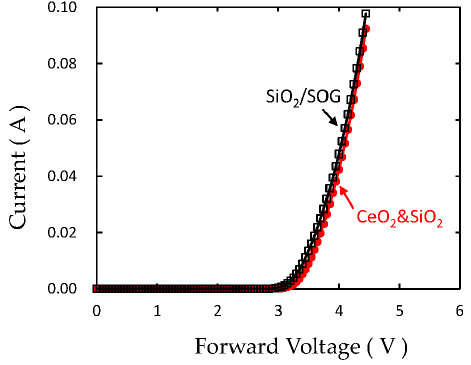
Figure 6. Forward bias characteristics of diodes.